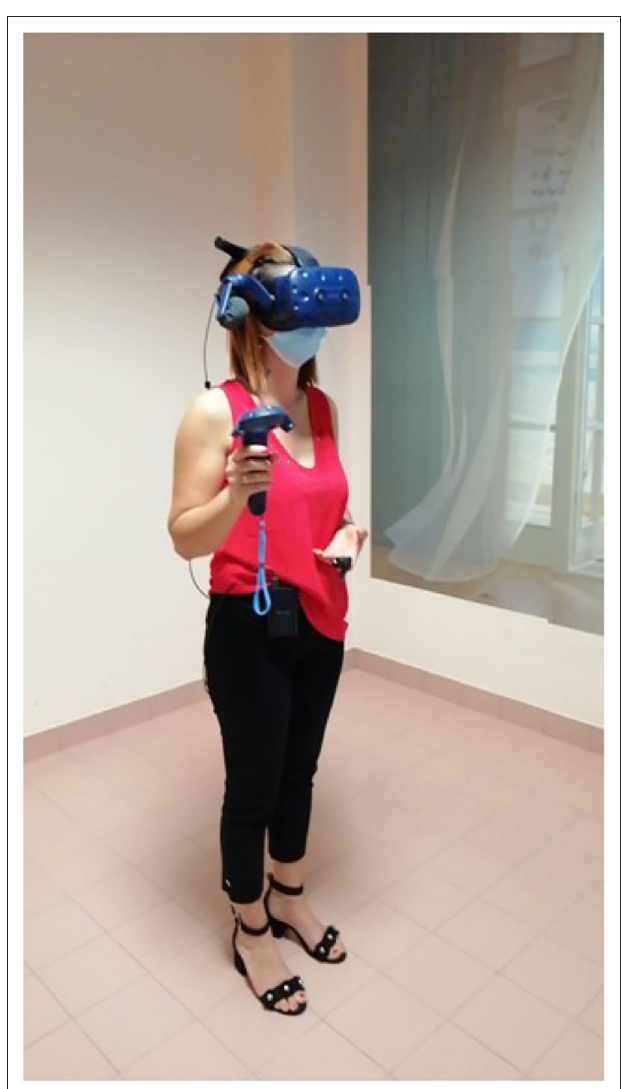
FIGURE 11 | An example of a subject wearing the virtual reality and biofeedback equipment.